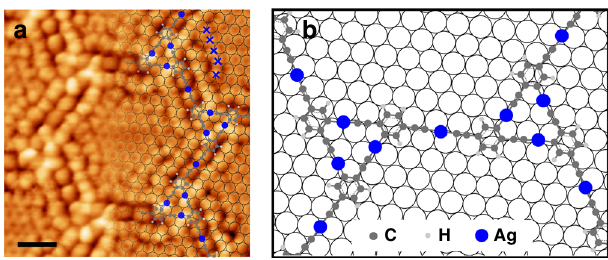
Fig. 6 Matching relationship between the 2D network and the Ag(111) substrate. a High-resolution STM image of the 2D network acquired with a modi fi ed tip (380 mV, 110pA, 77 K). Molecular models and substrate lattice are superimposed. Some detached Br atoms are highlighted by the blue crosses. Scale bar: 1 nm. b Molecular models of the 2D network on the